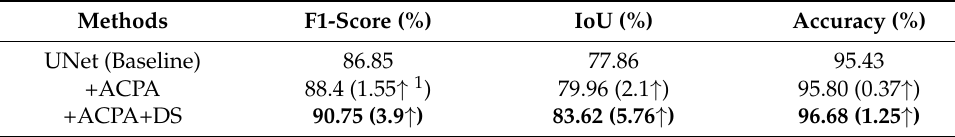
Table 1. Ablation study of each component inserted into the baseline. Methods F1-Score